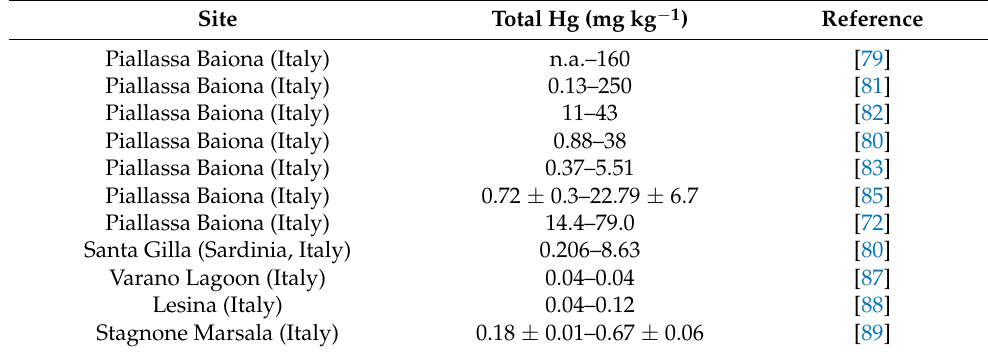
Table 2. Overview of total Hg in the sediments of some transitional environments in the Mediter- ranean